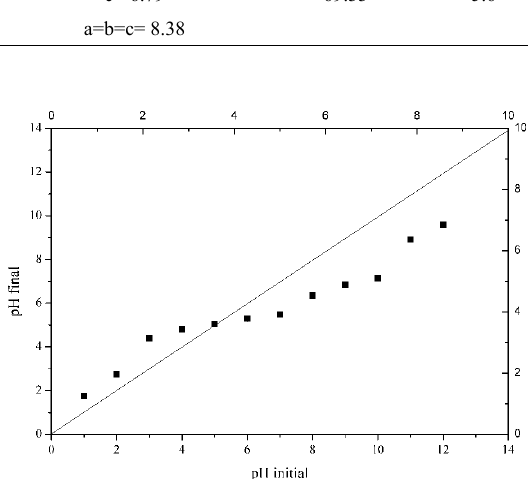
(pH initial value; pH final PZC